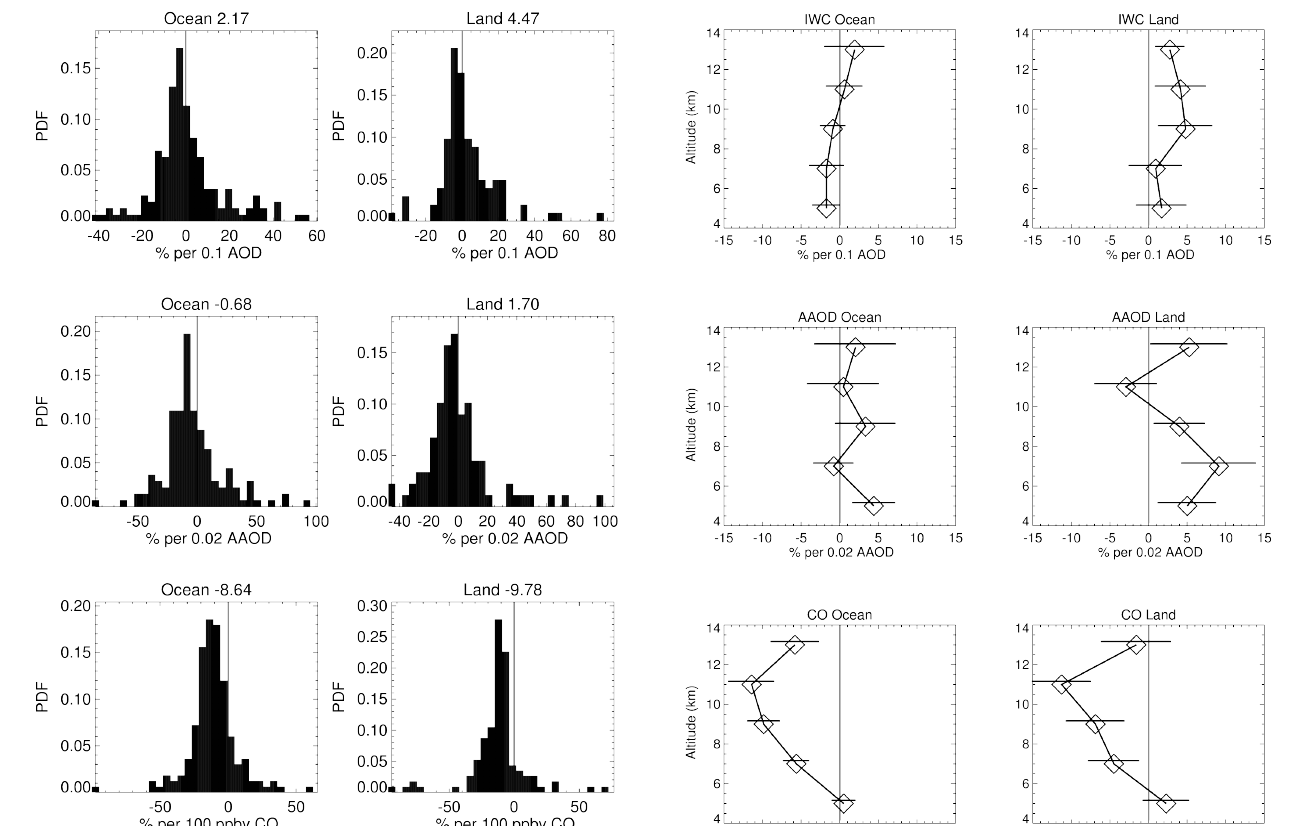
Figure 14. Average IWCreg derivatives over ocean and land for AOD, AAOD, and CO. Derivatives were used when they were less than 100% per 0.10 AOD, 100% per 0.02 AAOD, and 100% per 100ppbv CO. Confidence limits (1 σ) of the determination of the means are indicated by the horizontal